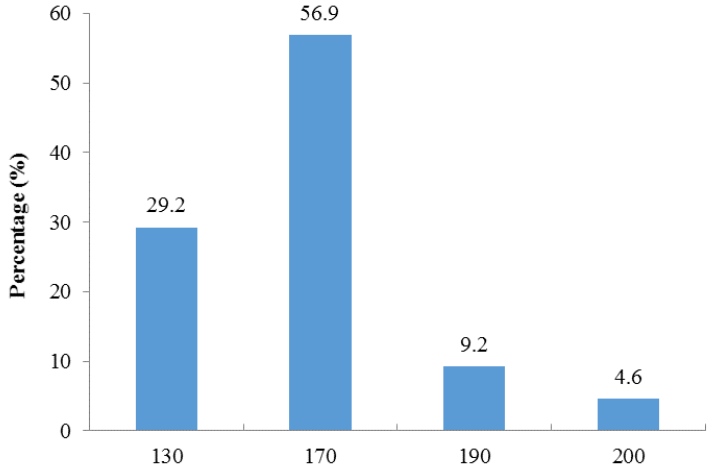
Figure 9. Distribution histogram of T V+Ni+Cu of the Guantao Formation in the Liaodong sub-uplift. All δ 13 C and δ 18 O values of the Neogene Guantao Formation are plotted in the third quadrant (Figure 10) of the lacustrine sedimentary type analysis chart, and they overlap with the typical open lake and humid climate zones, which indicates that the Guantao Formation mainly originates from freshwater, and the climate during its sedimentation period was warm and humid; the negative δ 13 C values are mainly related to